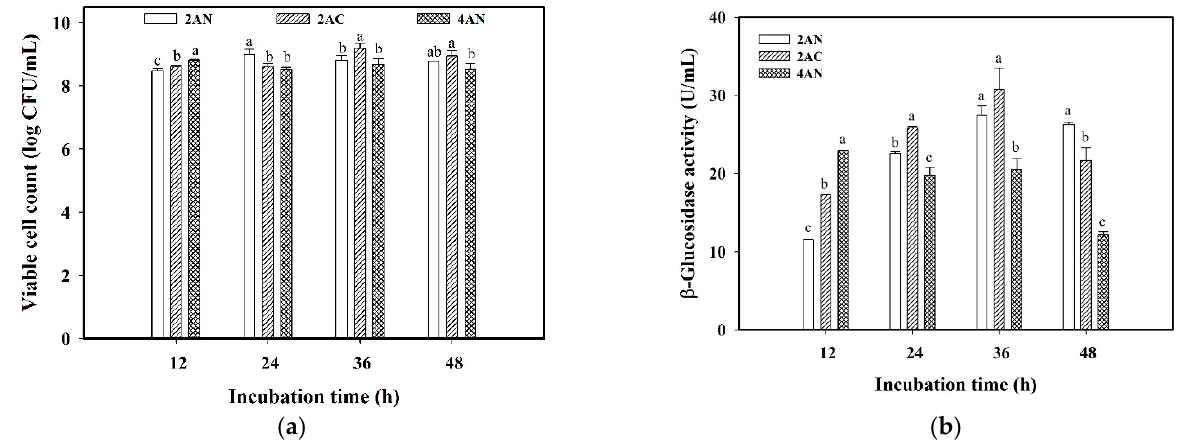
Figure 5. Variations of different encapsulation modes on ( a ) viable cell count and ( b ) β -glucosidase activity of encapsulated L. plantarum BCRC10357 in black soymilk at 37 °C. Encapsulation modes: 2% ALG/0.85% NaCl suspension (2AN), 2% ALG/0.5 mM choline chloride suspension (2AC), and 4% ALG/0.85% NaCl suspension (4AN). Data were expressed as mean ± standard deviation ( n = 3). Different superscript letters at the same incubation time were significantly different ( p < 0.05) by Duncan’s multiple range